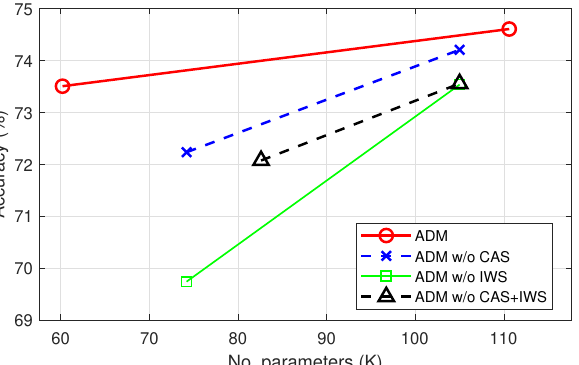
Figure 8. Ablation study on Mini-ImageNet. The results of the dotted lines were collected from independently trained models. CAS = cost-adaptive search, and IWS = instance-wise